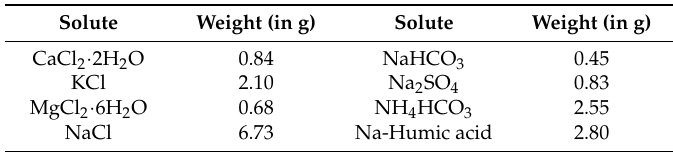
Table 1. Solutes used for the preparation of 1 L synthetic leachate.